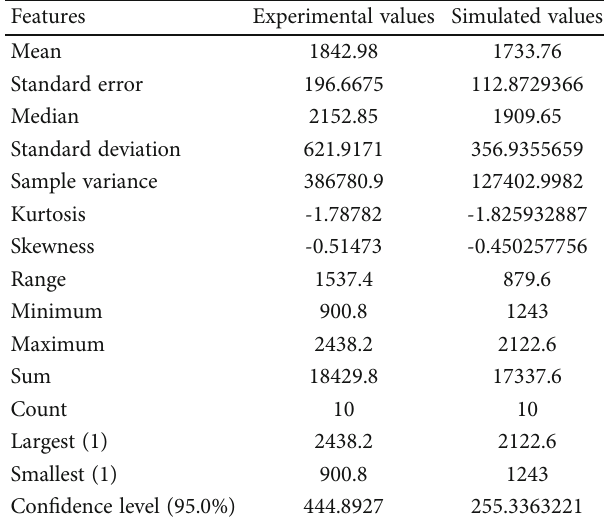
Table 4: Statistics (extracted features) based on performance analysis of polyperk modules.